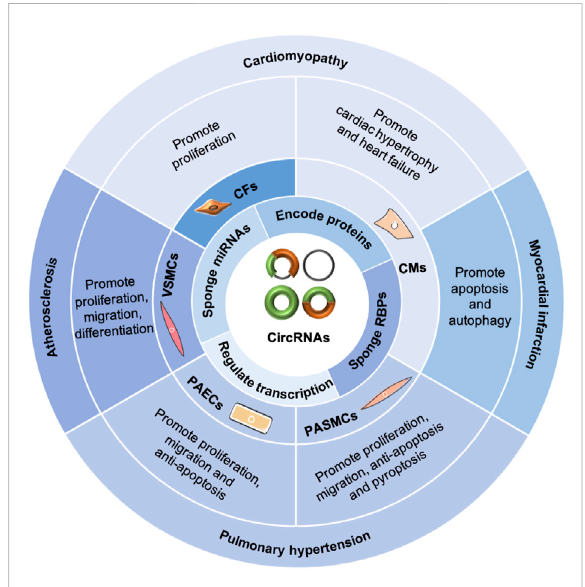
FIGURE 3 Functions of circRNAs in CVDs. CircRNAs exert functions in CVDs by sponging miRNAs and RBPs, encoding proteins, and regulating transcription. In the cardiovascular system, circRNAs are involved with cardiac fi broblasts (CFs), cardiomyocytes (CMs), pulmonary arterial smooth muscle cells (PASMCs), pulmonary arterial endothelial cells (PAECs), and vascular smooth muscle cells (VSMCs), playing important roles in the pathogenesis of cardiomyopathy, myocardial infarction, pulmonary hypertension, and